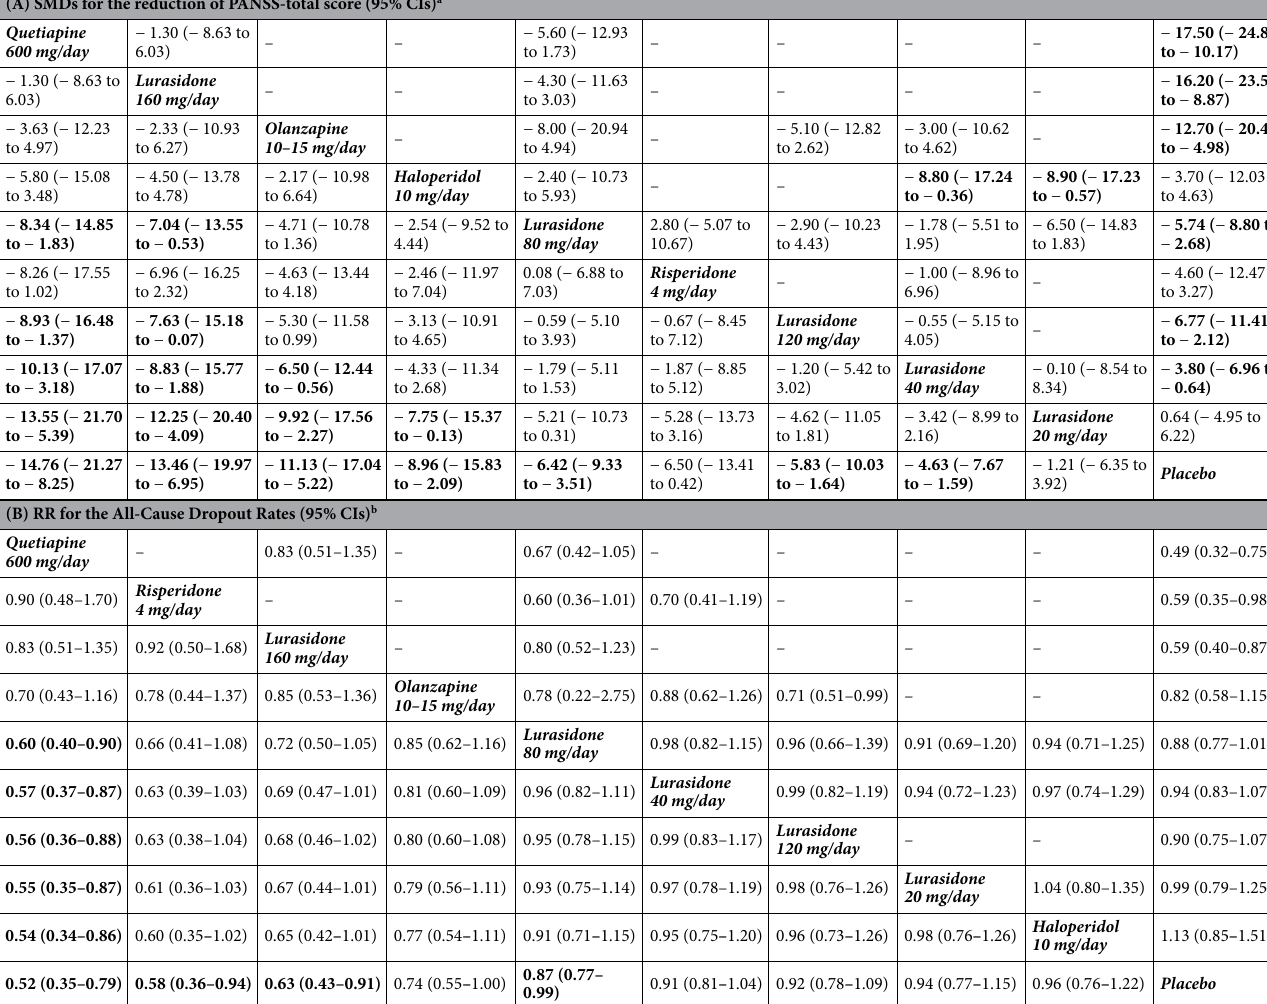
Table 2. League tables presenting network meta-analysis estimates: (lower triangle) and direct estimates (upper triangle): primary efficacy and acceptability outcomes of lurasidone at different doses and placebo for schizophrenia. a A mean difference (MD) less than 0 indicates the superiority of treatment defined in the column over the other treatment defined in the row. b An odd ratio (OR) less than 1 indicates the fewer events of treatment defined in the column over the other treatment defined in the row. − indicates the nonavailability of direct estimate. Treatments are reported in order of ranking of efficacy. Comparison treatments should be read from left to right, and the MD or RR is in the cell in common between the column-defining treatment and the row-defining treatment. A bold estimate indicates the significant difference between the treatment